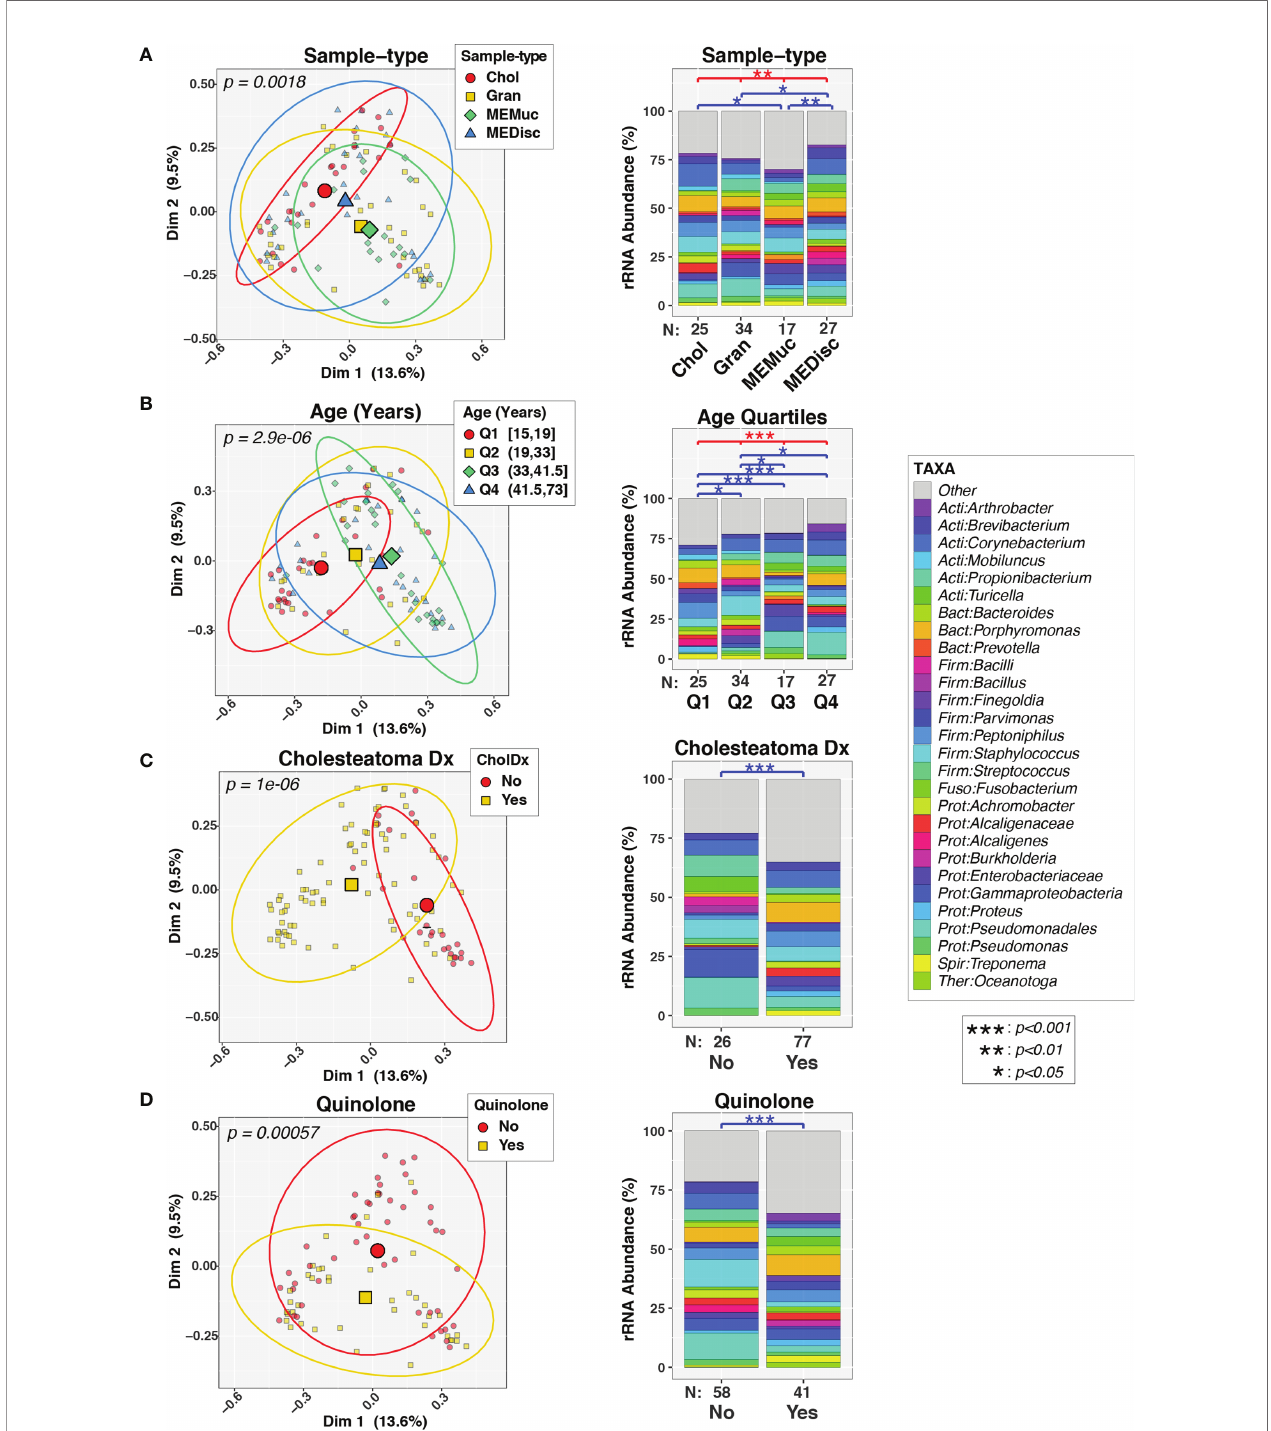
FIGURE 1 | Variability in composition of middle ear microbiota. Pairs of plots show beta-diversity across sample-types (A) , age quartiles (B) , cholesteatoma diagnosis (C) , or quinolone use (D) . The left column displays principal coordinates analysis (PCoA) plots of the fi rst two PC axes, color- and symbol-coded by the indicated variables. Smaller symbols designate individual subjects while larger symbols represent group means along both PC axes. Ellipses designate 90% con fi dence level for a multivariate t-distribution. The right column displays barcharts summarizing the mean relative abundances of predominant taxa (>2%RA) in each group; rarer taxa are grouped into the “ Other ” category. Results of PERMANOVA tests are indicated above barcharts. Red lines/symbols indicate p-values across all 4 groups. Blue lines/symbols indicate FDR-corrected p-values for pairwise